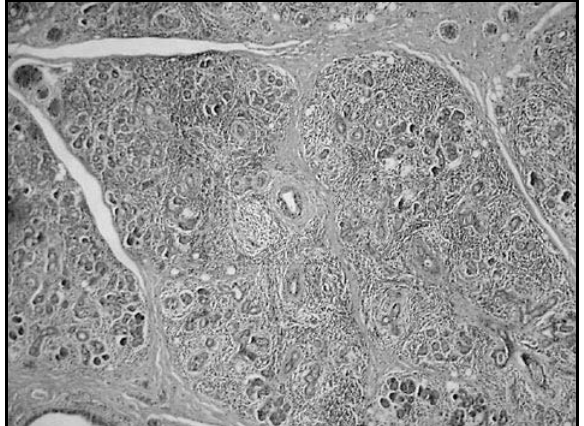
Figura 2 – Infiltrado inflamatório provocando destruição dos